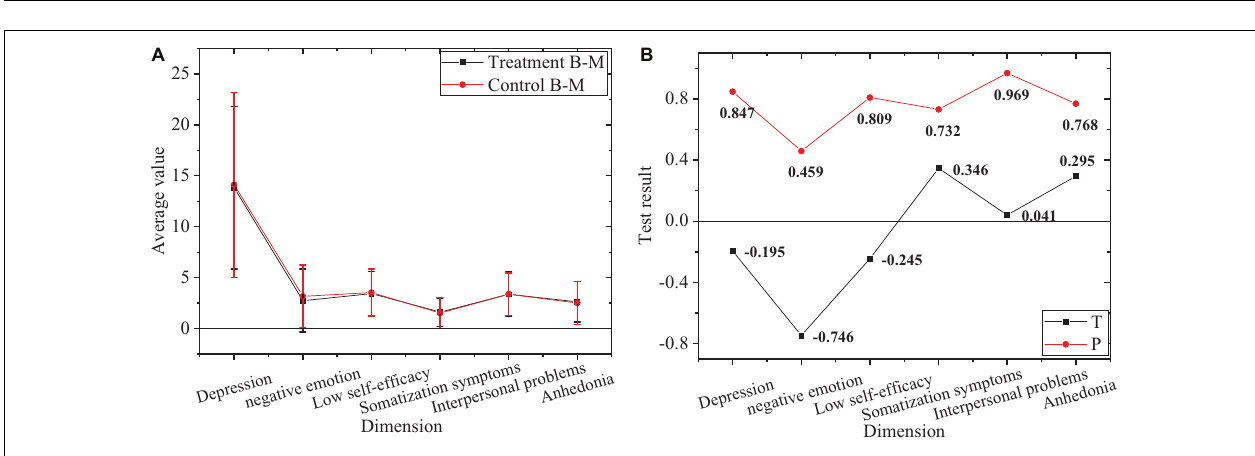
FIGURE 5 | Comparison of negative emotions. (A) Average of male subjects in the treatment group and control group. (B) Value of T and P of male subjects in the treatment group and control group.